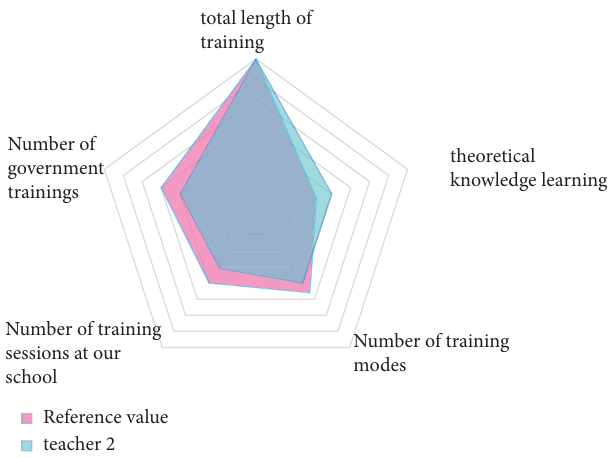
Figure 8: Teachers’ participation in the dimension of informati- zation